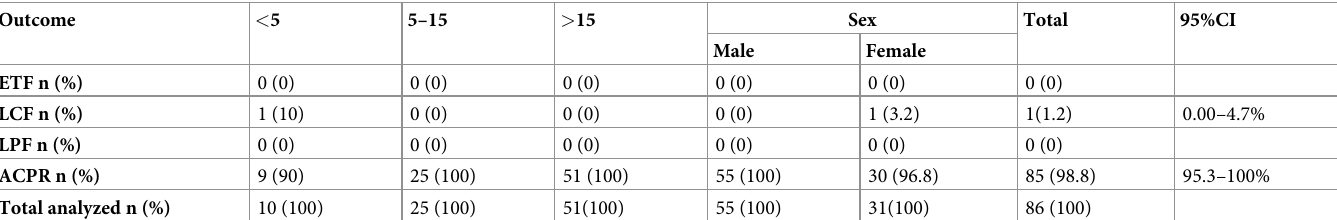
Table 2. Per protocol treatment outcome chloroquine at day 28, Shewa Robit Health Center, northeast Ethiopia from November 2020 to March 2021.